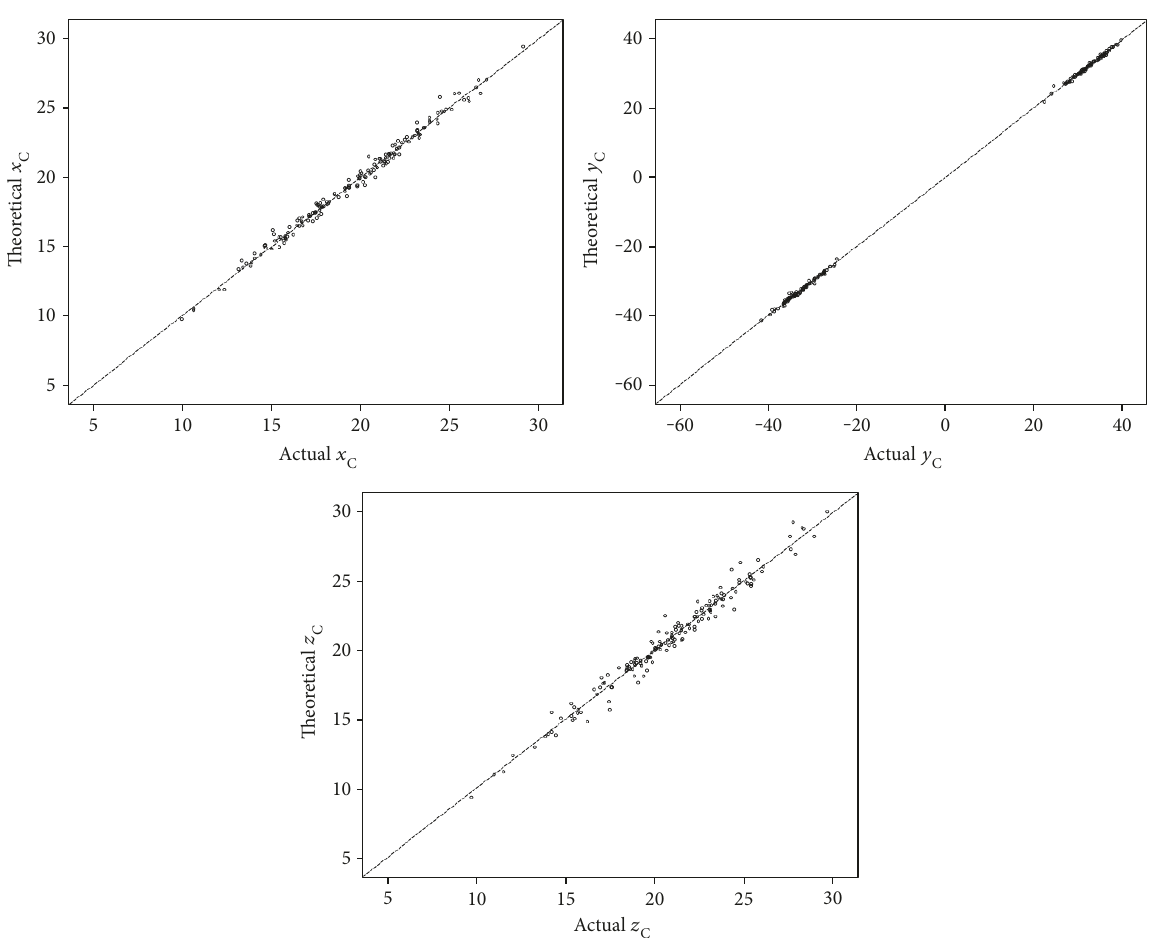
Figure 5: The scatterplots about the theoretical and actual coordinates of the corneal apex. The dotted line represents the equation y = x , and we could fi nd that the theoretical values were consistent with the actual values near